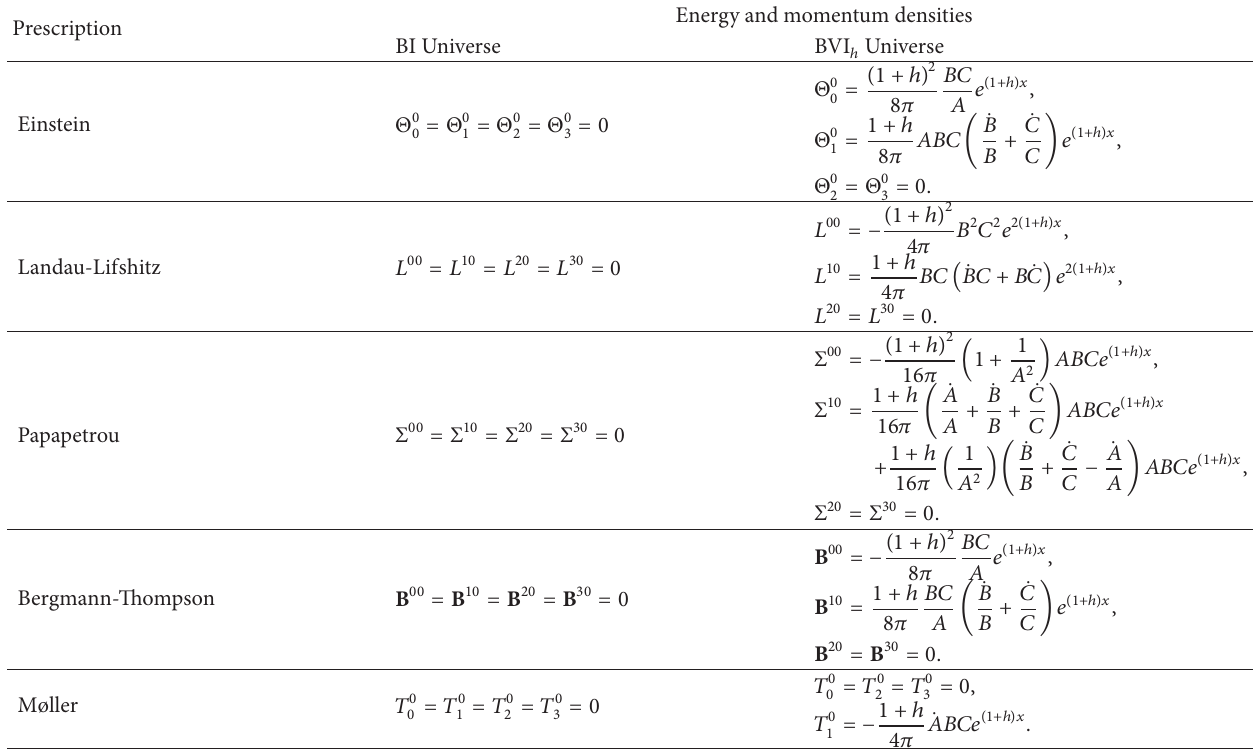
Table 3: Energy and momentum densities for BI and BVI ℎ Universes.